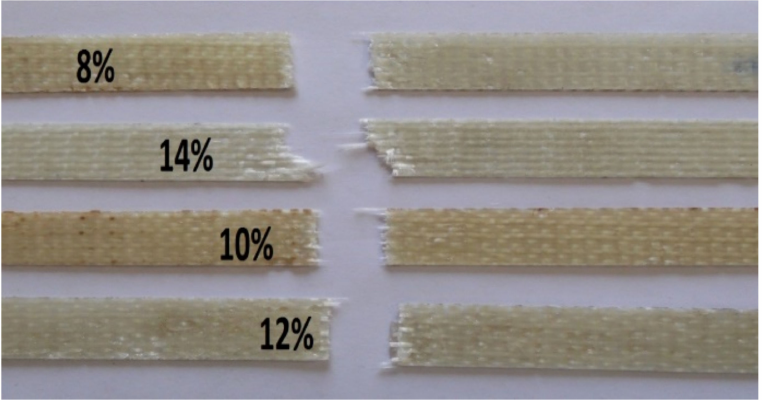
Figure 6. Nature of tensile failure in 3D woven glass–epoxy composites with different hardener